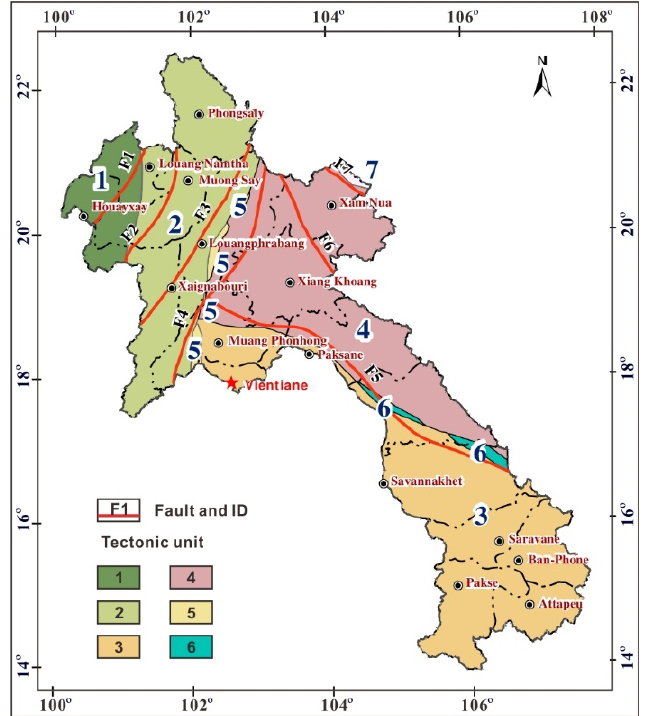
Figure 1. Tectonic sketch of Laos (modified from [27,28]). Tectonic units: 1—Jinghong-Sukhothai arc;